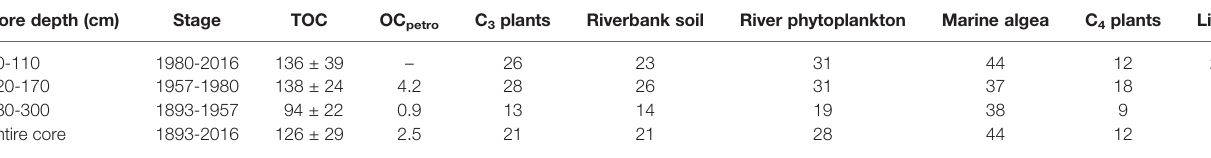
TABLE 3 | Burial rate (g C m -2 yr -1 ) of the TOC and each end-member. Core depth